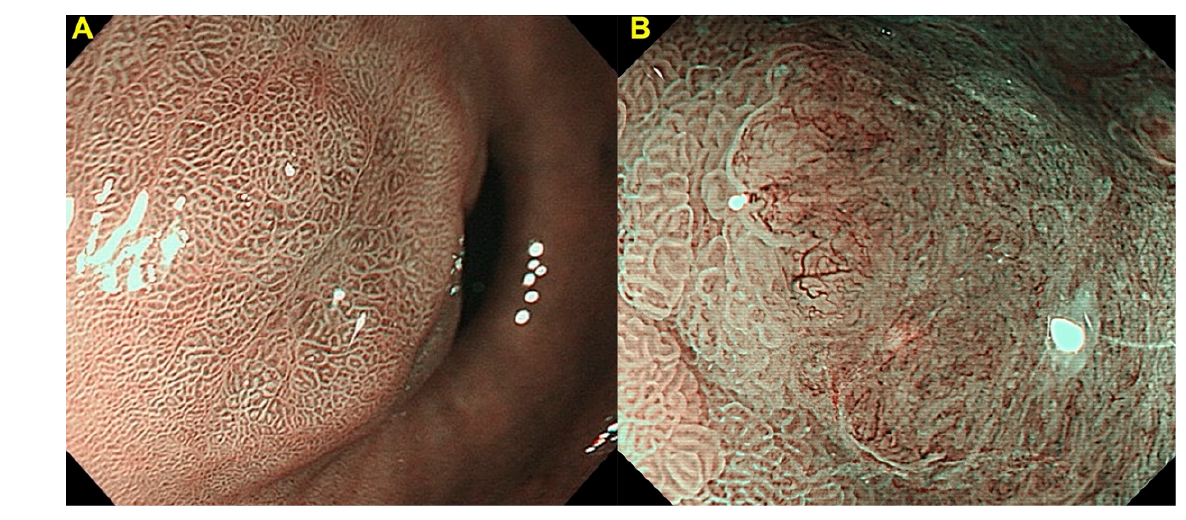
Figure 3. Gastric UMEC: ( A ) UMEC 1/2A is considered as non-cancer and ( B ) UMEC 2B/3 is considered as cancer. Table 3. Outline of UMEC in the stomach.